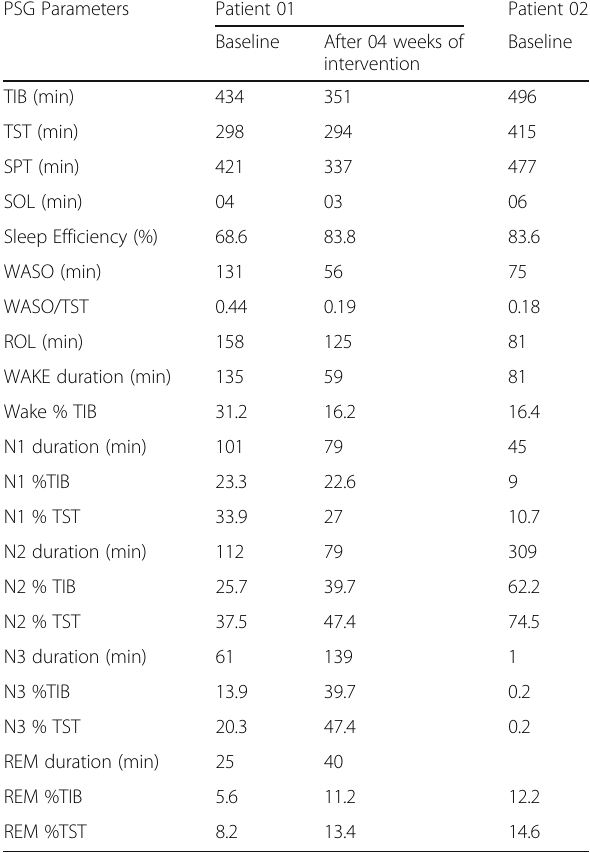
Table 3 PSG parameters of both patients PSG